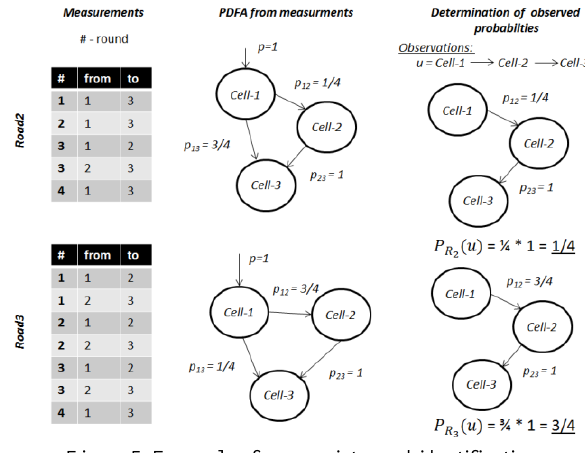
Figure 5. Example of appropriate road identification Figure 5. shows an example of using PDFA to determine the appropriate road (based on the test case detailed in Figure 4).